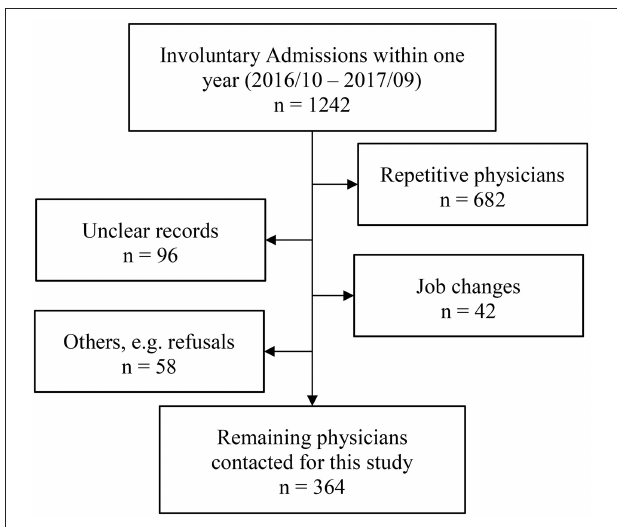
FIGURE 1 | Selection of referring